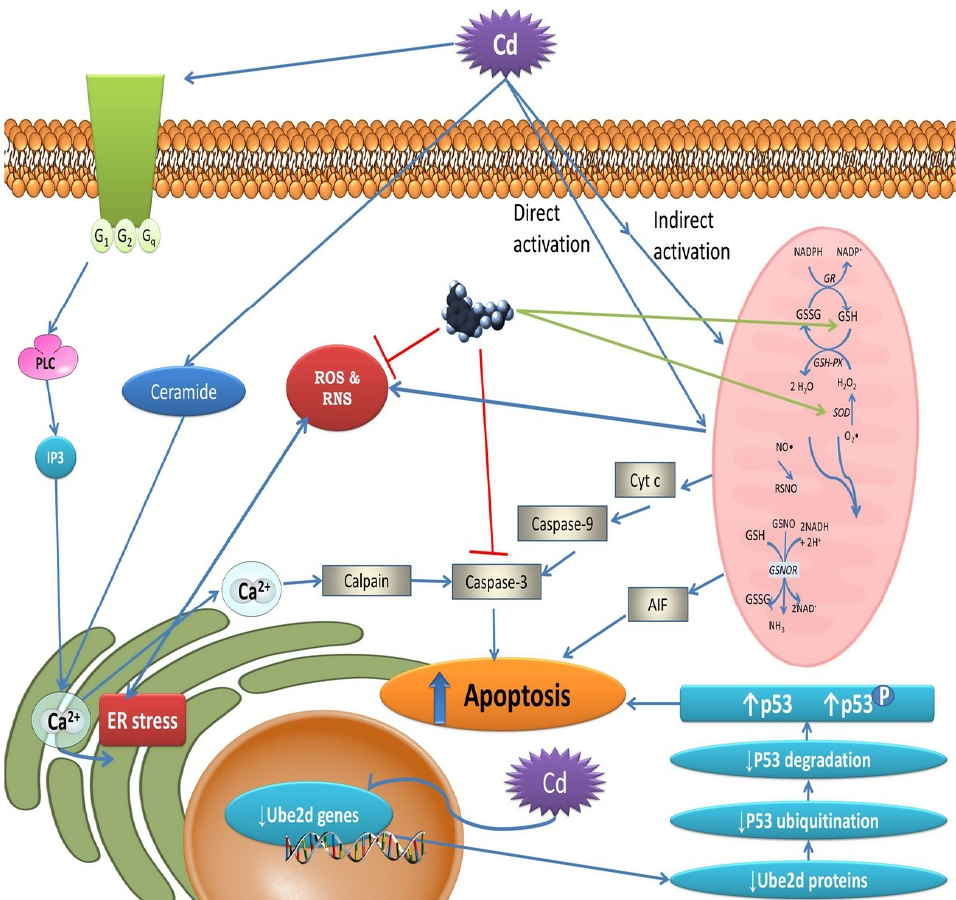
Figure 2. Presumptive cadmium pathways that cause cellular oxidative stress and leave damaged molecules in their wake. Cd induces endoplasmic reticulum (ER) stress by calcium overload through direct activation of ceramide and binding to protein G-coupled receptors. The increased intracellular Ca 2+ induces calpain–caspase-3-mediated apoptosis. Cd both directly and indirectly promotes the formation of mitochondrial-derived ROS/RNS and releases the pro-apoptotic regulator cytochrome c (Cyt c), which stimulates caspase-3-mediated apoptosis. Cd downregulates Ube2d genes, thereby inhibiting P53 degradation, which causes P53 overload and the promotion of apoptosis. Melatonin counteracts Cd damage by blocking caspase-3 and reduces the ER stress caused by ROS/RNS. Melatonin also activates antioxidative enzymes and the GSH/GSSG cycle. From Romero et al. [12], with